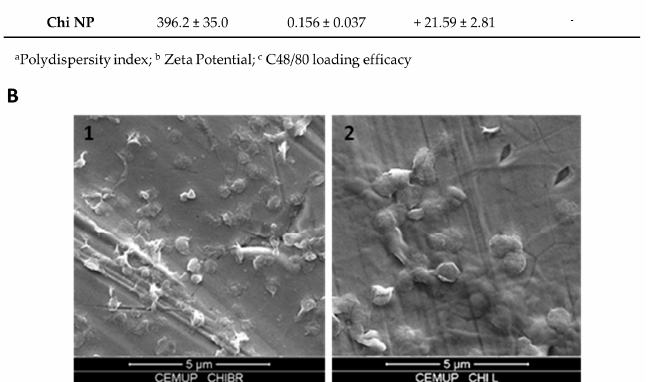
Figure 2. Characterization of C48/80 loaded and unloaded chitosan nanoparticles. ( A ) Size and zeta potential were measured by dynamic light scattering and electrophoretic light scattering, respectively, with a Delsa™ Nano C. C48/80 loading efficacy was measured by a colorimetric method. Mean ± SD, n ≥ 3. ( B ) SEM images of ( 1 ) Chi NP and ( 2 ) Chi-C48/80 NP. Magnification 15,000×, scale 5 µ